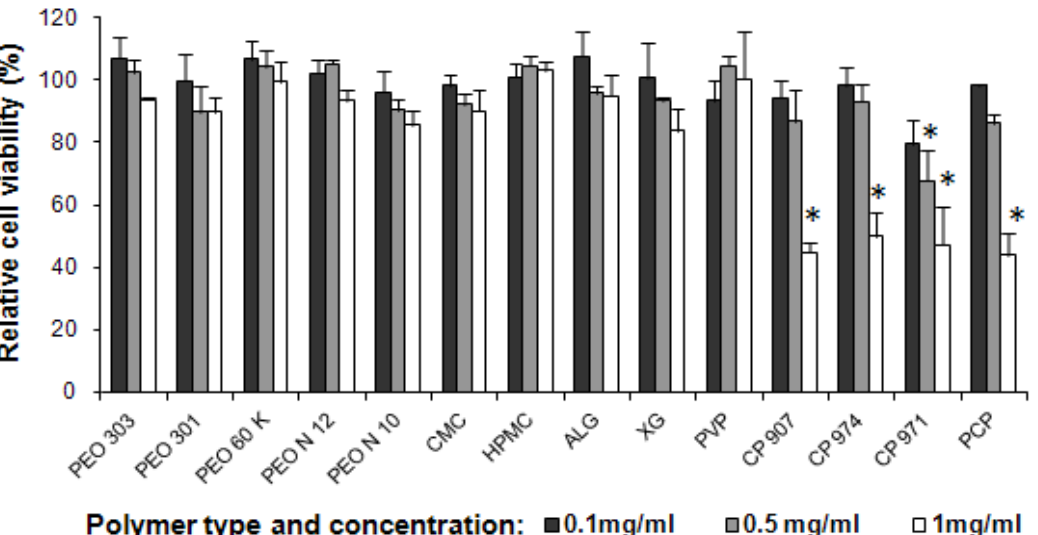
Figure 3. MAC-T cell viability in various concentrations of different polymers after 72 h. Black (0.1 mg/mL), Grey (0.5 mg/mL) and white (1 mg/mL) bars depict the concentration of each polymer. Cell viability was detected by MTT assay (mean ± SD, n = 3) and expressed as a percentage of cell viability in untreated control cells. The standard deviation is shown by the error bars. * denotes significance from negative control. (Legend: polyethylene oxide (PEO): MW 7 M (PEO 303), MW 4 M (PEO 301), MW 2 M (PEO 60 K), MW 1 M (PEO N 12), MW 100,000 (PEO N 10), hydroxypropylmethyl cellulose (HPMC), carboxymethyl cellulose sodium (CMC), sodium alginate (ALG), xanthan gum (XG), polyvinyl pyrrolidone (PVP) and carbopols (CP 907, CP 974P, CP 971P) polycarbophil (PCP). PEO, HPMC, CMC, ALG and PVP solutions at the highest concentration of 1 mg/mL showed no significant reduction in cell viability compared to the negative control (Figure